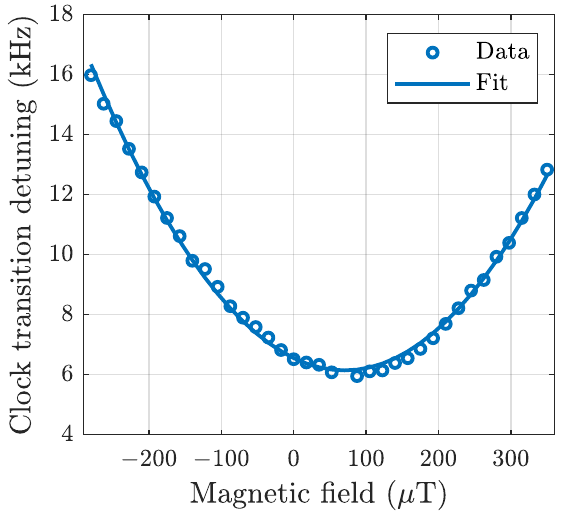
Figure 10. Experimentally measured clock transition frequency as a function of applied magnetic field longitudinal to the Raman beam propagation